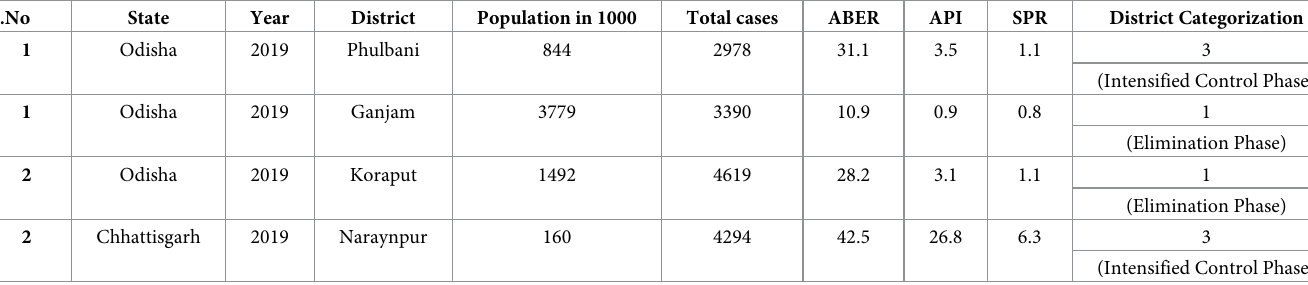
Table 3. Comparison of API and SPR with respect to population size and